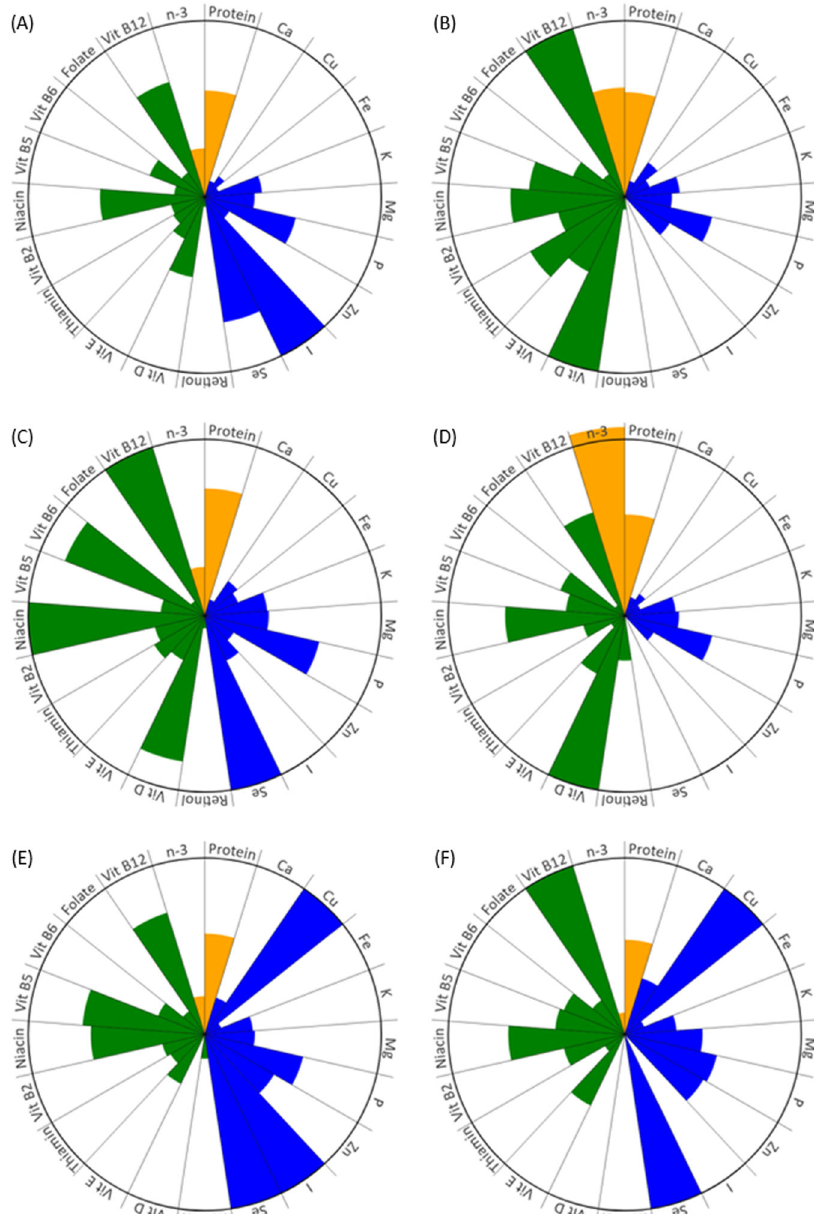
Fig. 4 Differing nutrient pro fi les of seafoods. Nutrient pro fi les of six seafood species as percentage contribution of 100 g raw edible fl esh to the dietary reference intake: Atlantic cod ( A ), Common carp ( B ), Albacore ( C ), Largehead hairtail ( D ), American lobster ( E ), and Gazami crab ( F ). The twenty-one nutrients included in the NDS 21 formula are represented here, plus selenium and iodine (not available for Common carp or Largehead hairtail; iodine not available for Gazami crab). Nutrients are grouped by proteins and fats (orange), minerals (blue), and vitamins (green). Values are displayed as relative area of the pie slice, with a maximum value (full slice) representing a 100% contribution. All nutrients with the exception of n-3 are capped to 100% when exceeding the